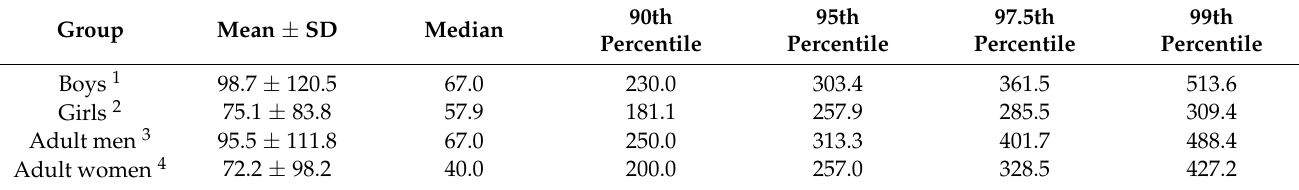
Table 1. The daily intake of wheat-based products for inhabitants in Shanghai (g/d).